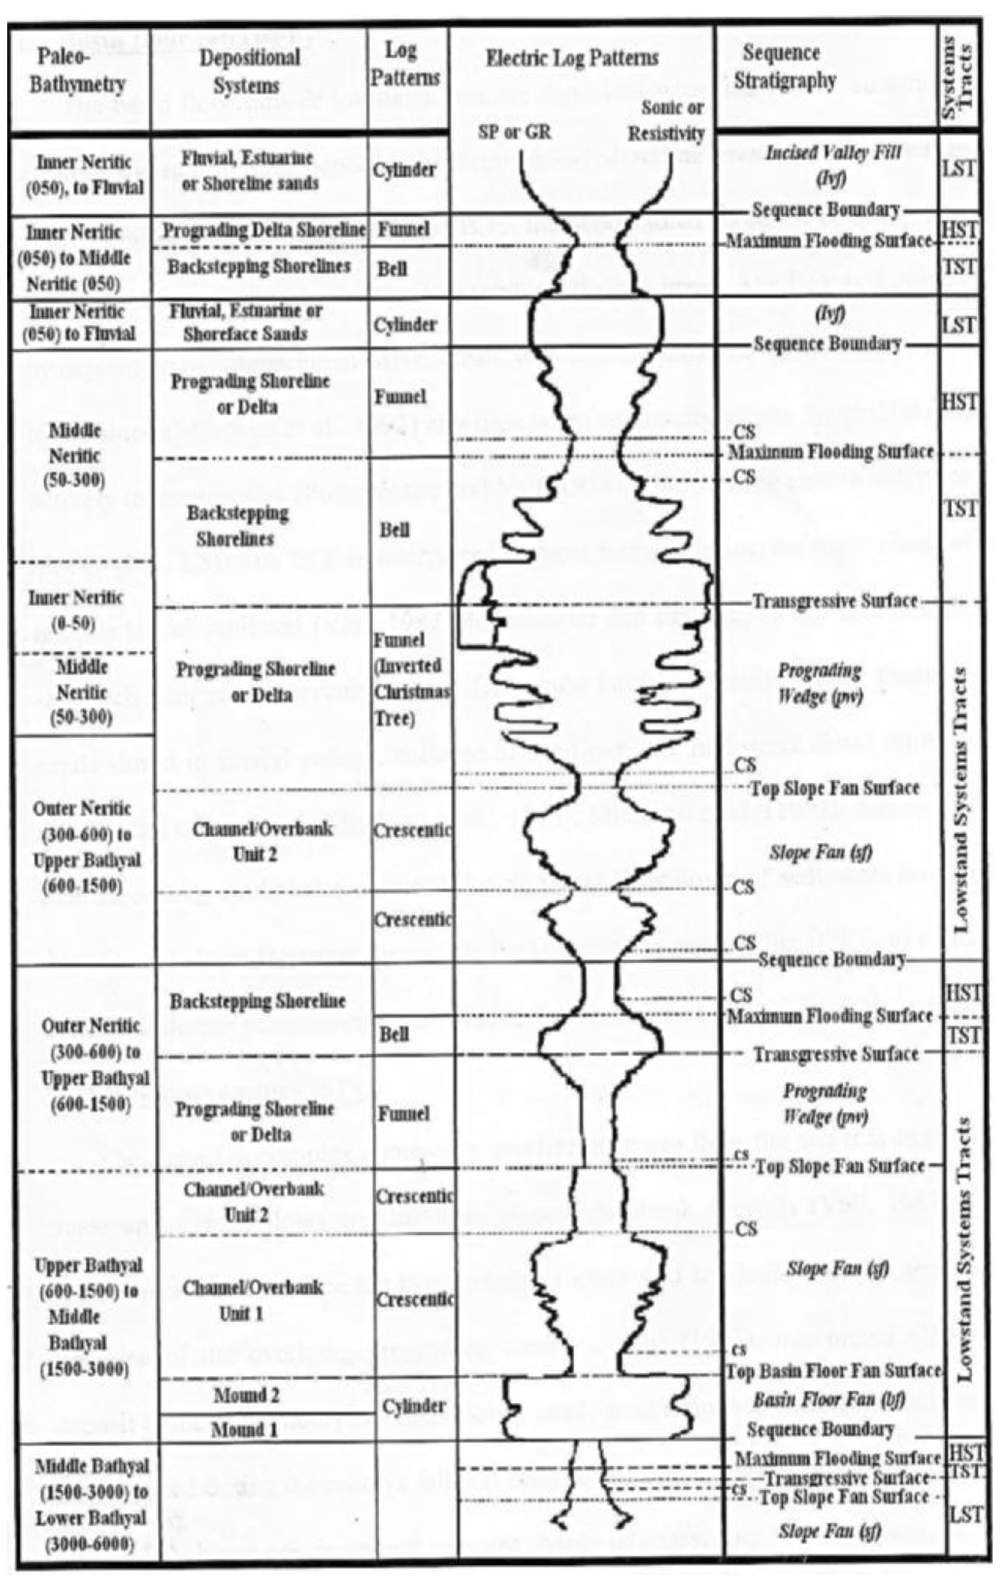
Fig. 6 Typical Log patterns associated with Gulf of Mexico depositional sequences and systems tract (after Vail